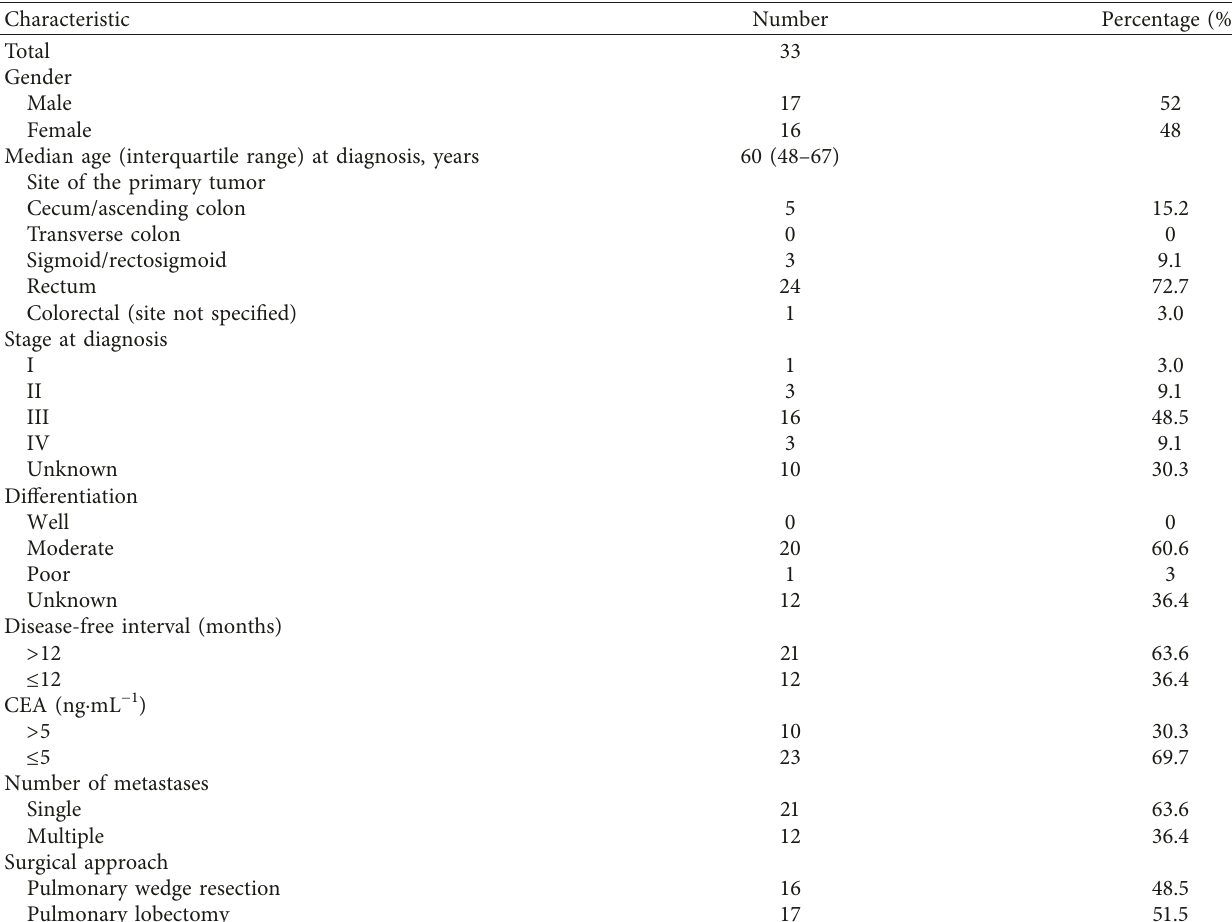
Table 1: General clinical data of 33 CRC patients with pulmonary